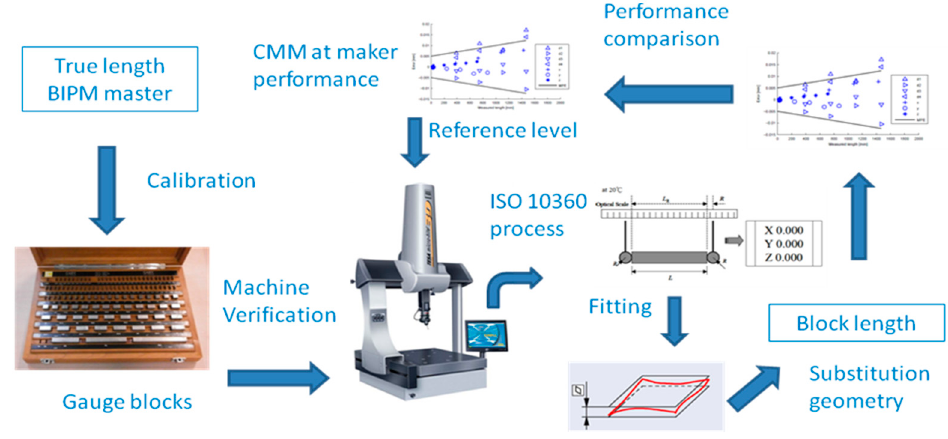
Figure 1. Sketch of a CMM verification process by ISO 10360-2.